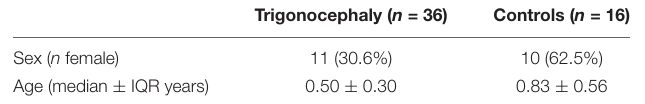
Frontiers in Neuroscience |